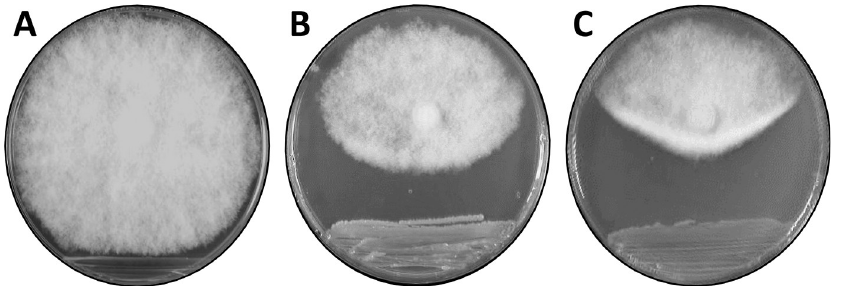
bee gut isolate 28H4Tw4.20 (inhibition, > 30%), and ( C ) Pseudomonas strain AN5 (inhibition, >